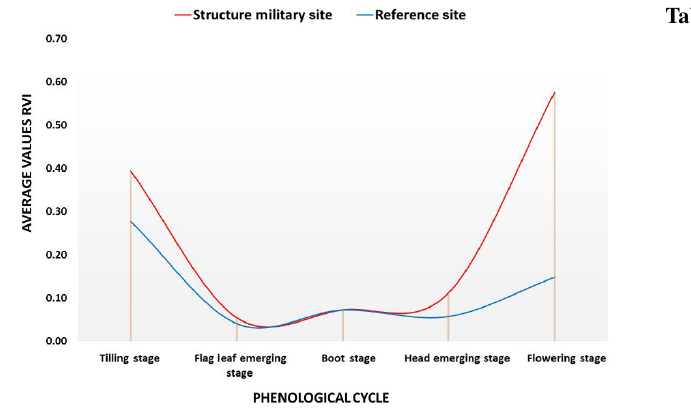
Figure 9. Same as Fig. 5, but for RVI.